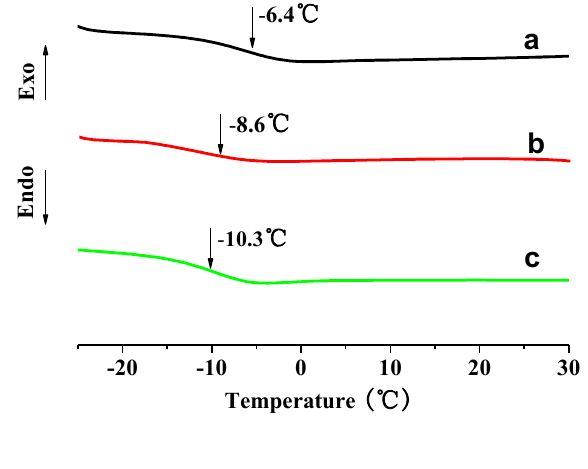
Figure 4. Differential scanning calorimeter (DSC) heating curves of PXGS with different feeding contents of Boc- L -glutamic acid: ( a ) PXGS 2:5-5%; ( b ) PXGS 2:5-10%; and ( c ) PXGS